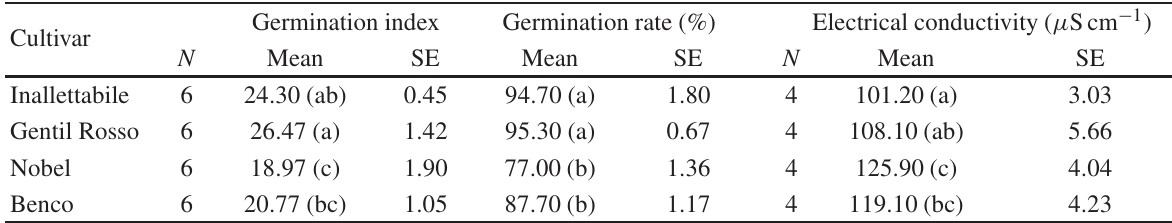
FIGURE 6: Correlation of data sets derived from the both evaluation approaches: visual evaluation and the local connected fractal dimension (LCFD). The wheat cultivars Inallettabile (INA), Gentil Rosso (GR), Nobel (NOB), and Benco (BEN) are signed by different indicator shapes. TABLE 3: Results of the seed vigor tests. Data are presented as mean values. Different letters indicate significant differences at P < 0 . 05